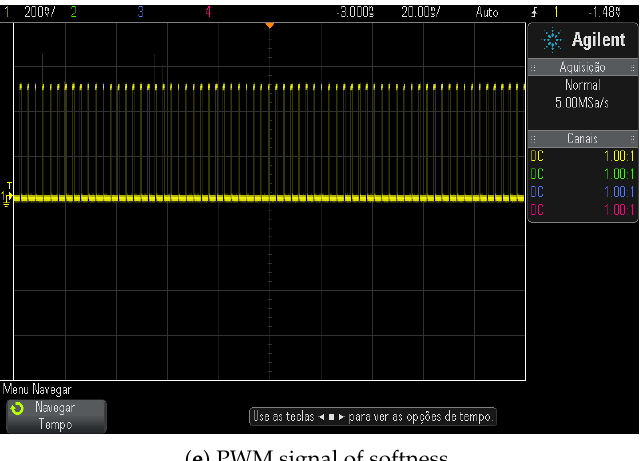
Figure 9. PWM signals of tactile